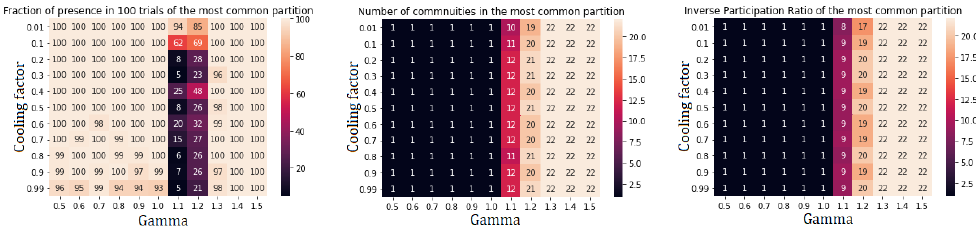
Figure A4. Performance indicators for Spin Glass algorithm applied to community I. There is no further subdivision.